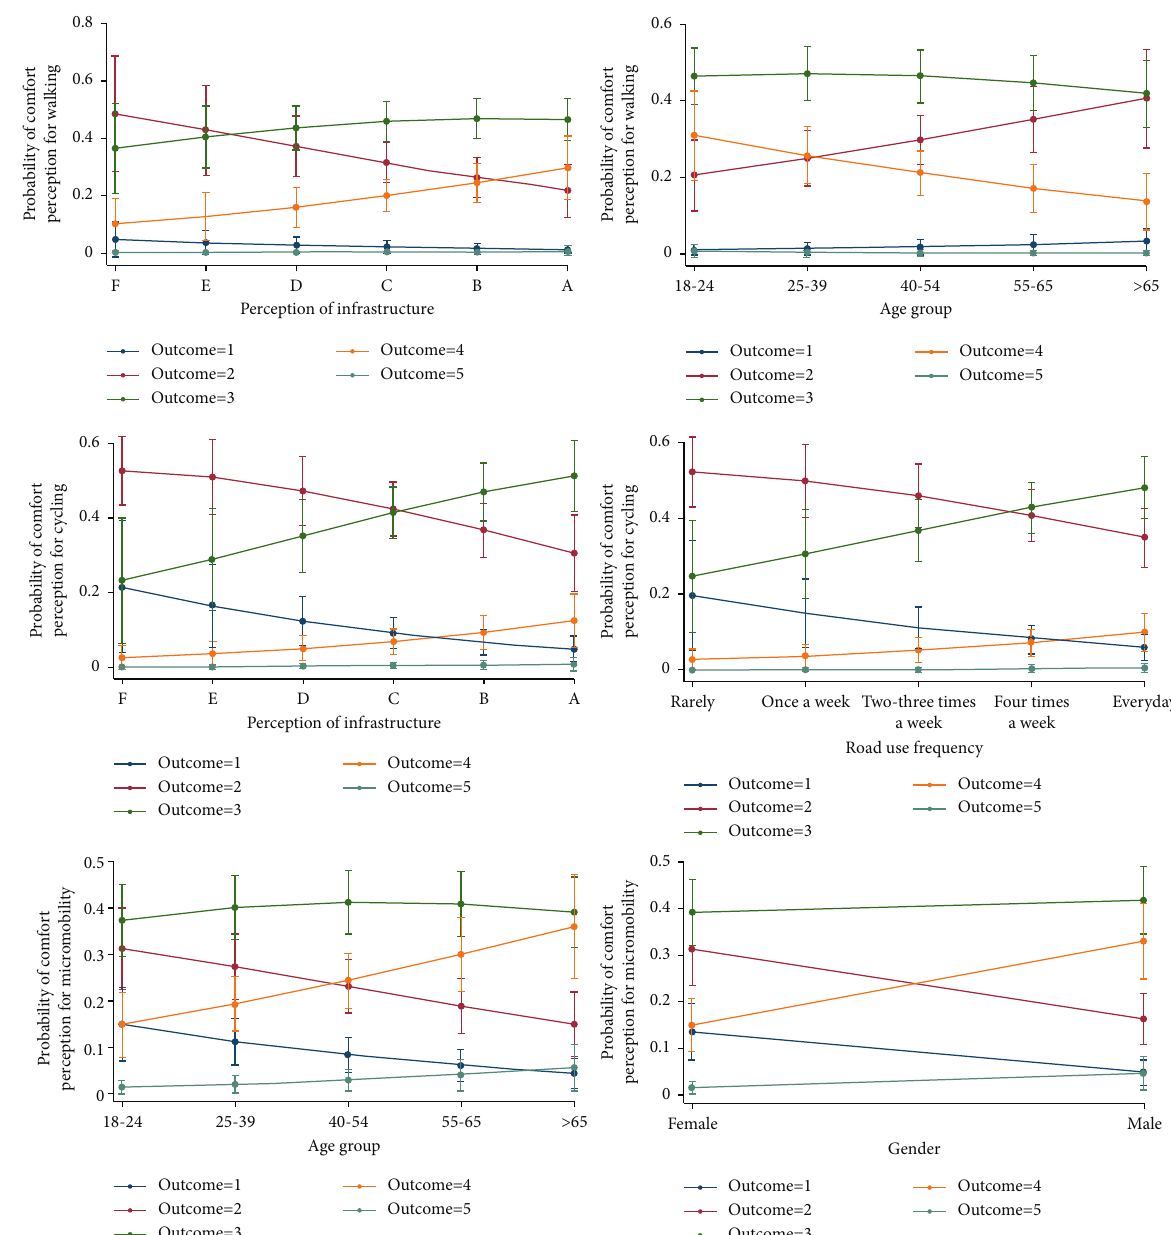
Figure 4: Predictive margins for comfort perception at 95% confidence